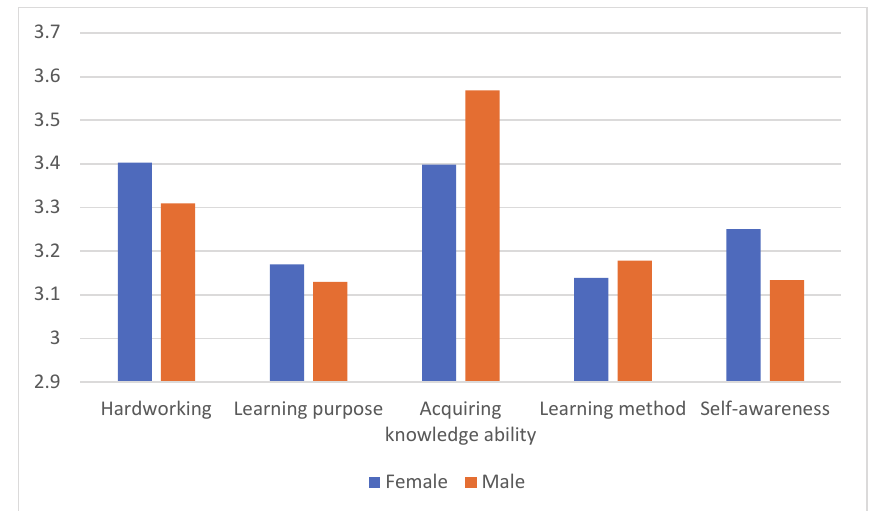
Fig. 3. The intrinsic factors affecting language